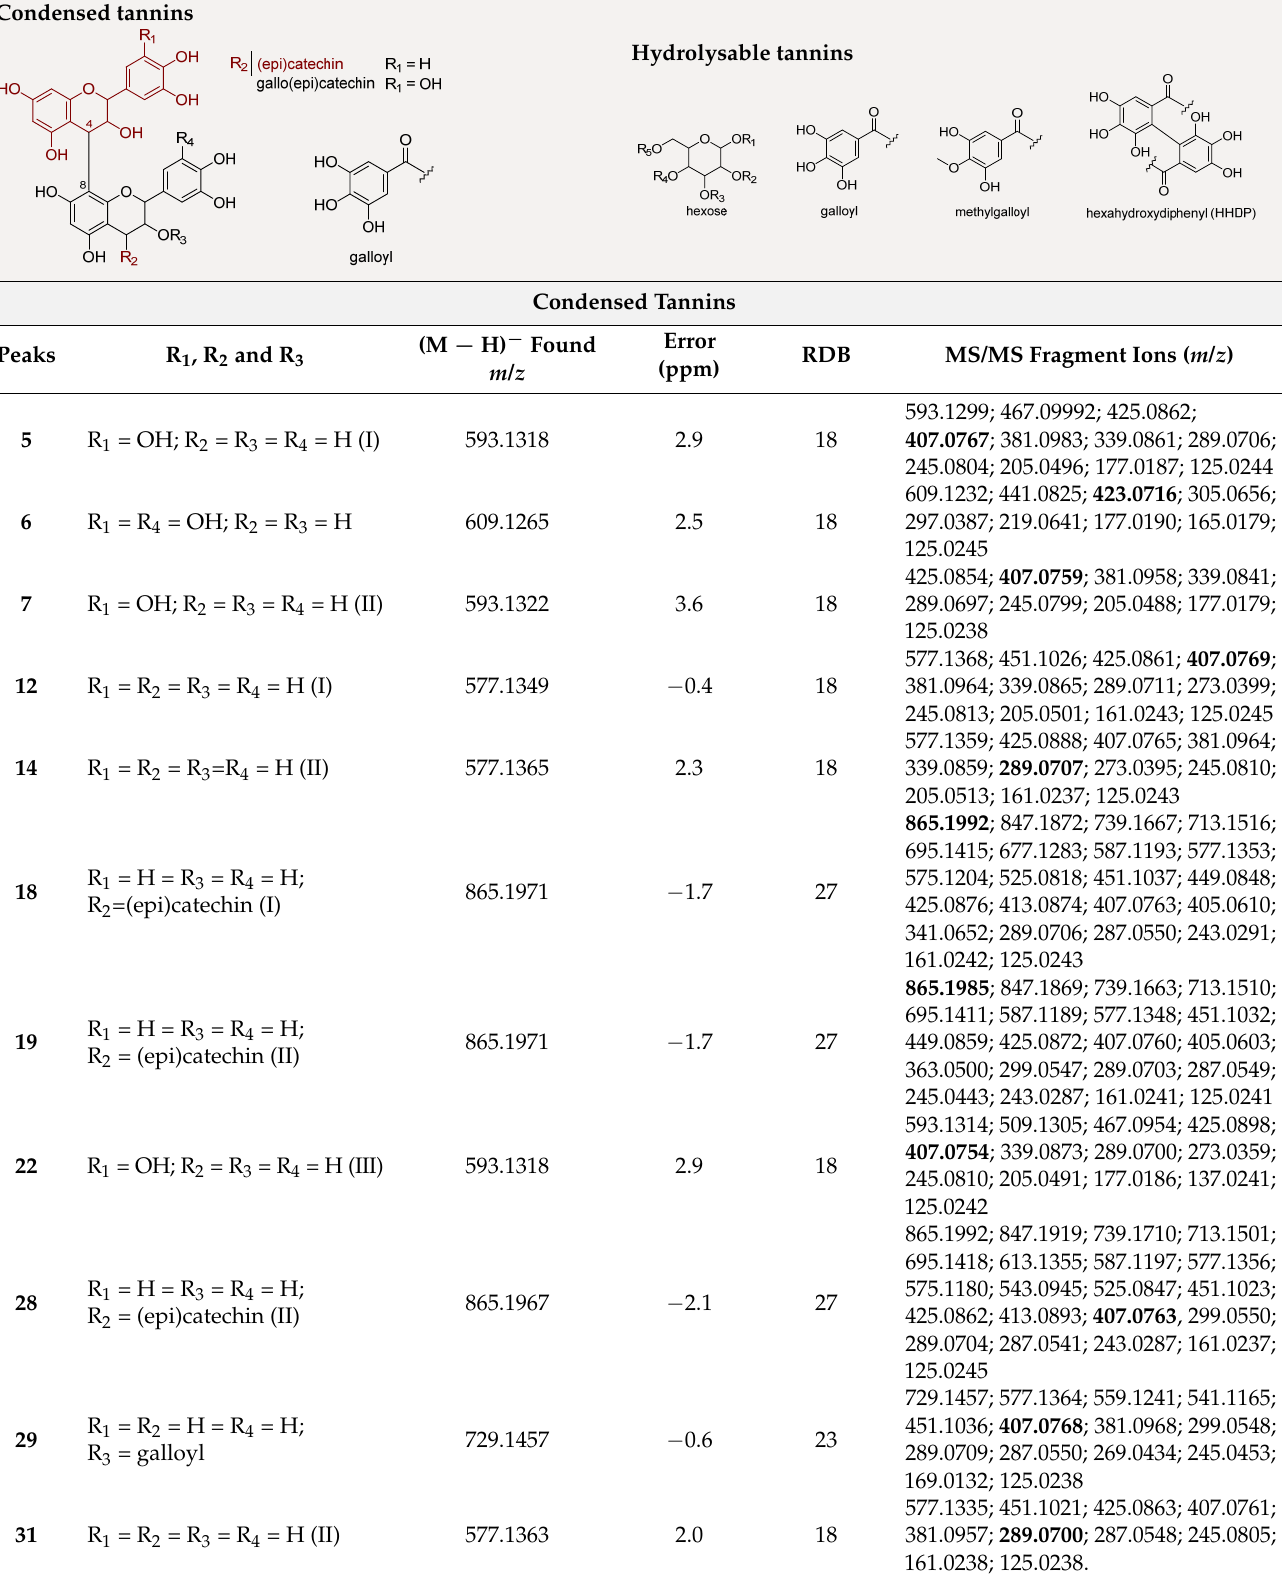
Table 1. TOF-MS data of hydrolysable and condensed tannins tentatively identified in oak leaf. RDB = ring double bond equivalent value. Base peak fragments are reported in bold.